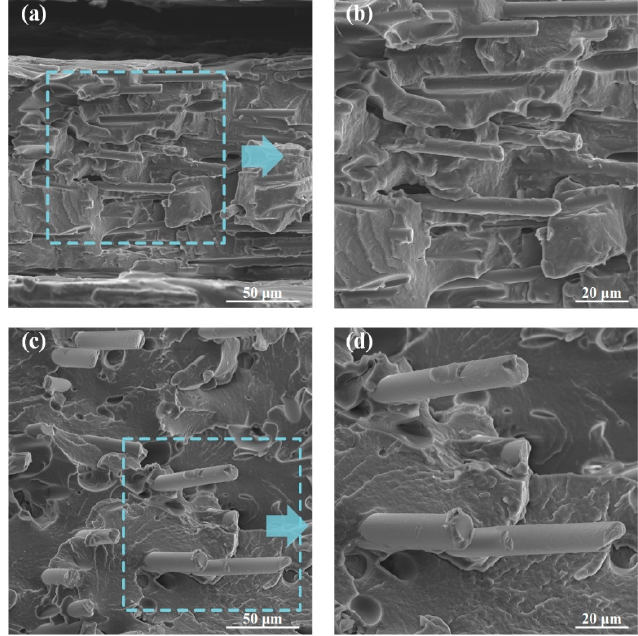
Figure 7. SEM images of printed ( a,b ) PACF and ( c,d ) PAGF composites built in a horizontal